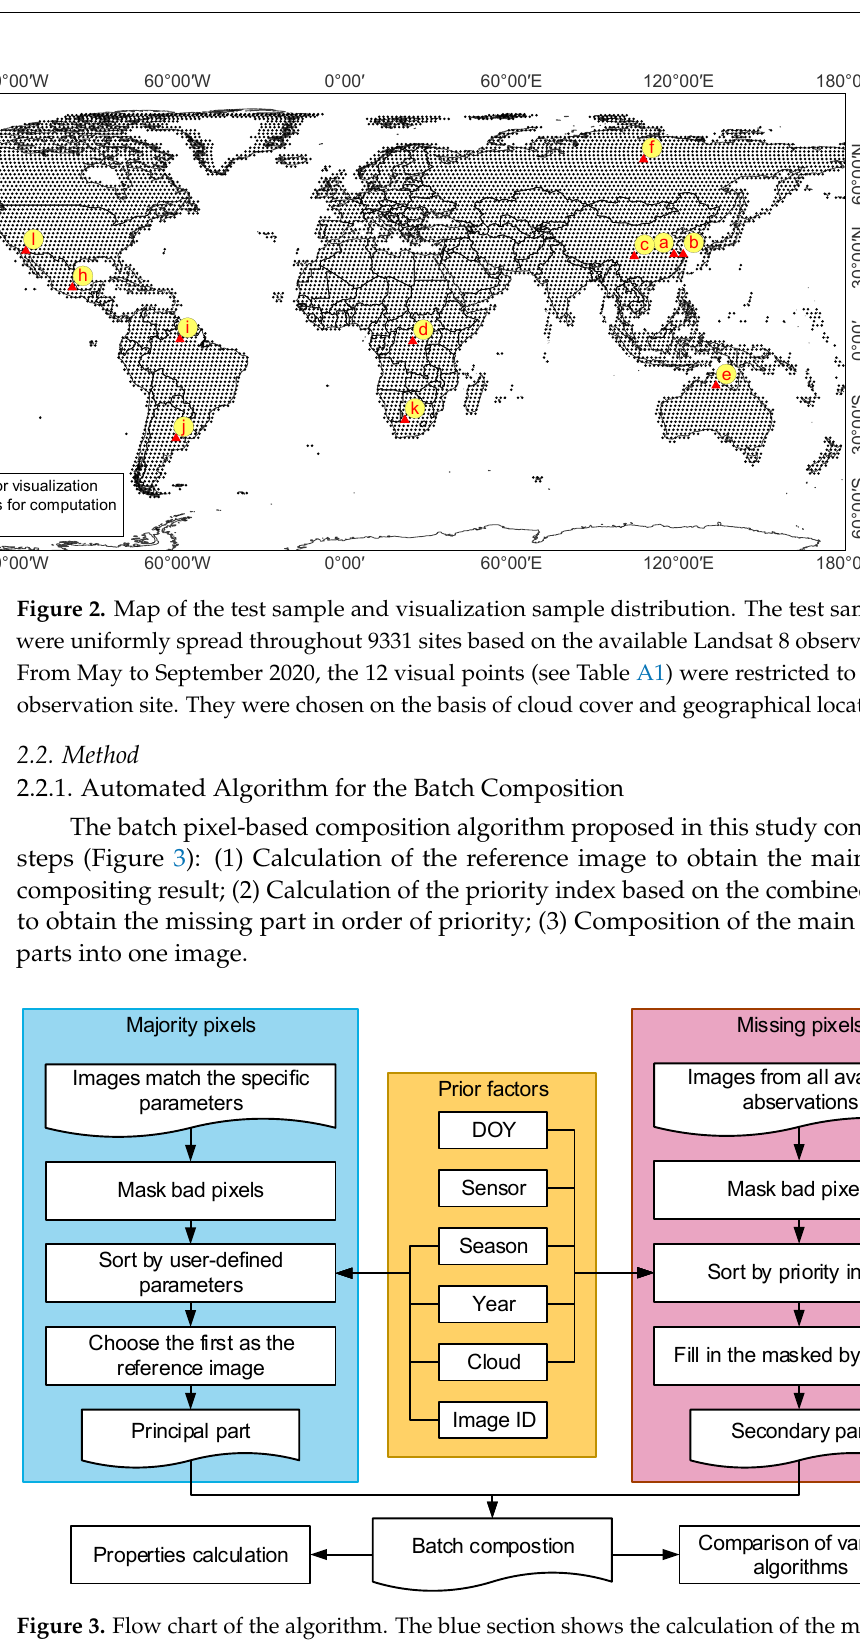
Figure 3. Flow chart of the algorithm. The blue section shows the calculation of the main part of the compositing result, the red section shows the method to compute the missing pixels except for the main part, and the yellow section describes the priority index